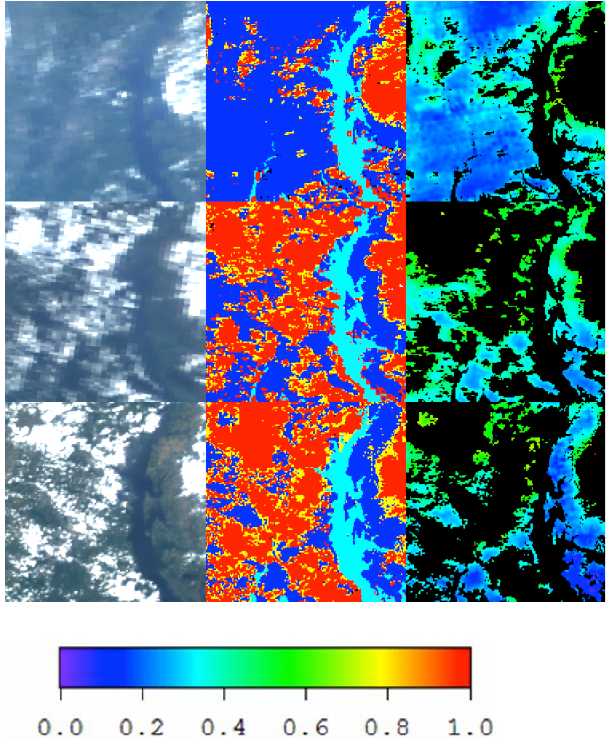
Figure 12. MODIS sensor images of 5 July 2011, Terra overpass at 15:15UTC (top), Terra overpass at 16:50UTC (middle), and Aqua overpass at 18:30UTC (bottom). The top-of-atmosphere (TOA) red–green–blue images (left), cloud masking (middle; red = cloud) and aerosol optical depth (right) are shown. The color scale is for the AOD (right side